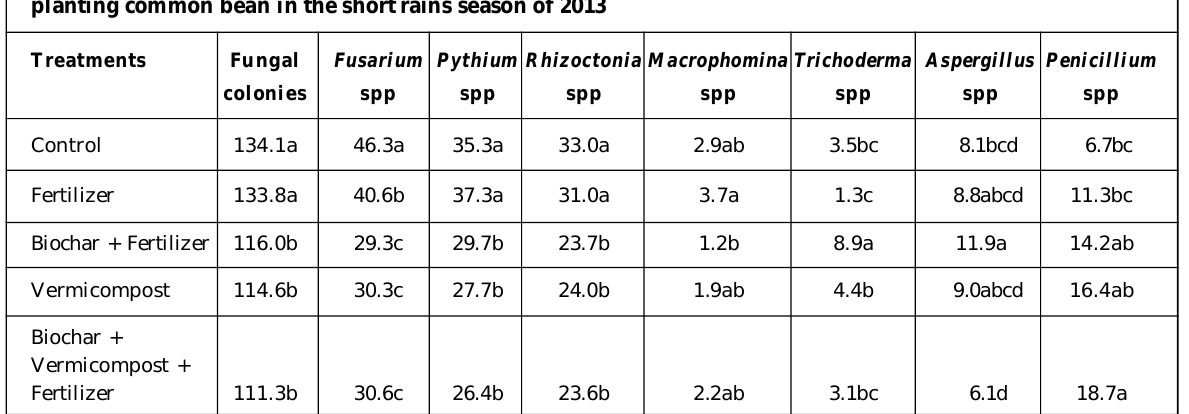
Table 7: Effect of biochar and vermicompost on fungal populations ( × 10 3 CFU/g soil) two weeks after planting common bean in the short rains season of 2013 Treatments